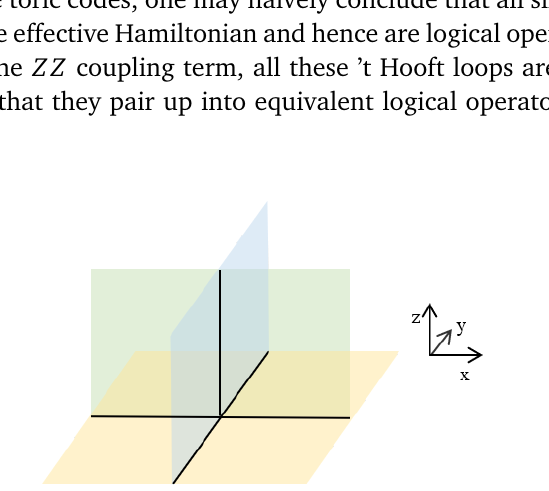
Figure 14: The minimal structure of an X-cube model with rough